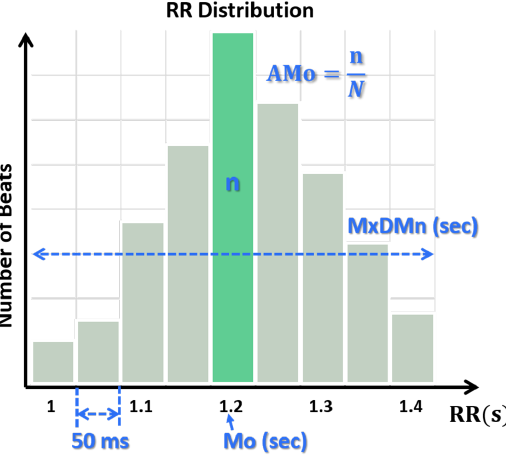
Figure 2. Histogram of the RR distribution for Baevsky’s stress index, in which n is the number of beats, N is successive beat intervals, AMo is the height of the histogram of the normalised RR interval, MxDMn represents the difference between the shortest and longest RR intervals, and Mo is the median of RR